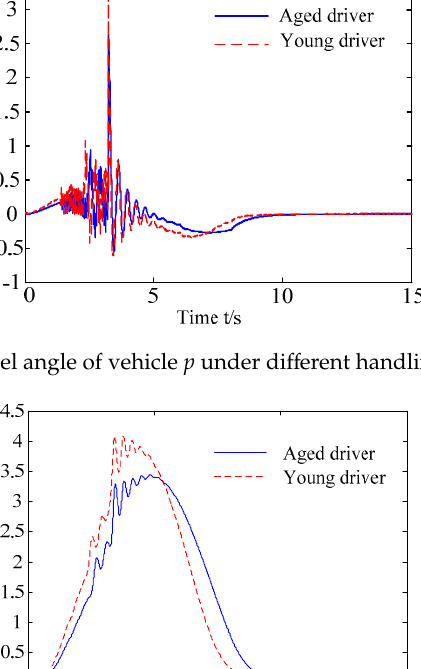
Figure 21. Longitudinal velocities of vehicle p under different handling characteristics.